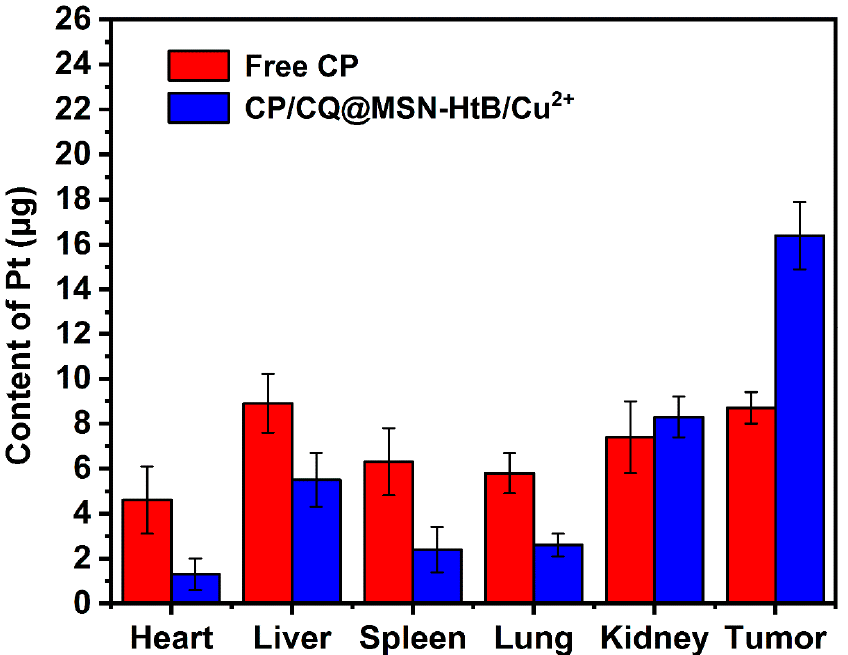
Figure 5. Contents of Pt in the major organs and tumor cells after intravenous injection of CP and CP/CQ@MSN − HtB/Cu 2+ NPs.